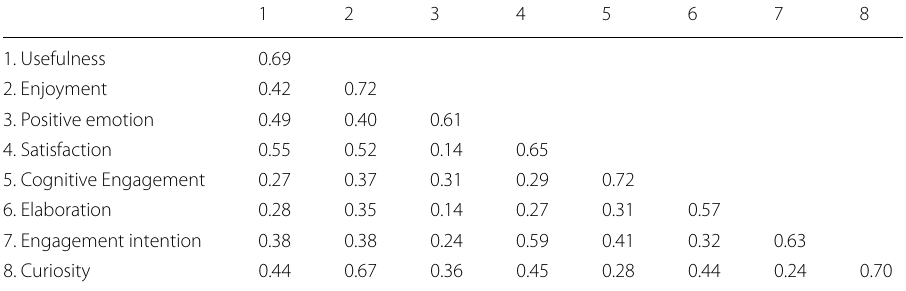
Table 3 Convergent and discriminant validity